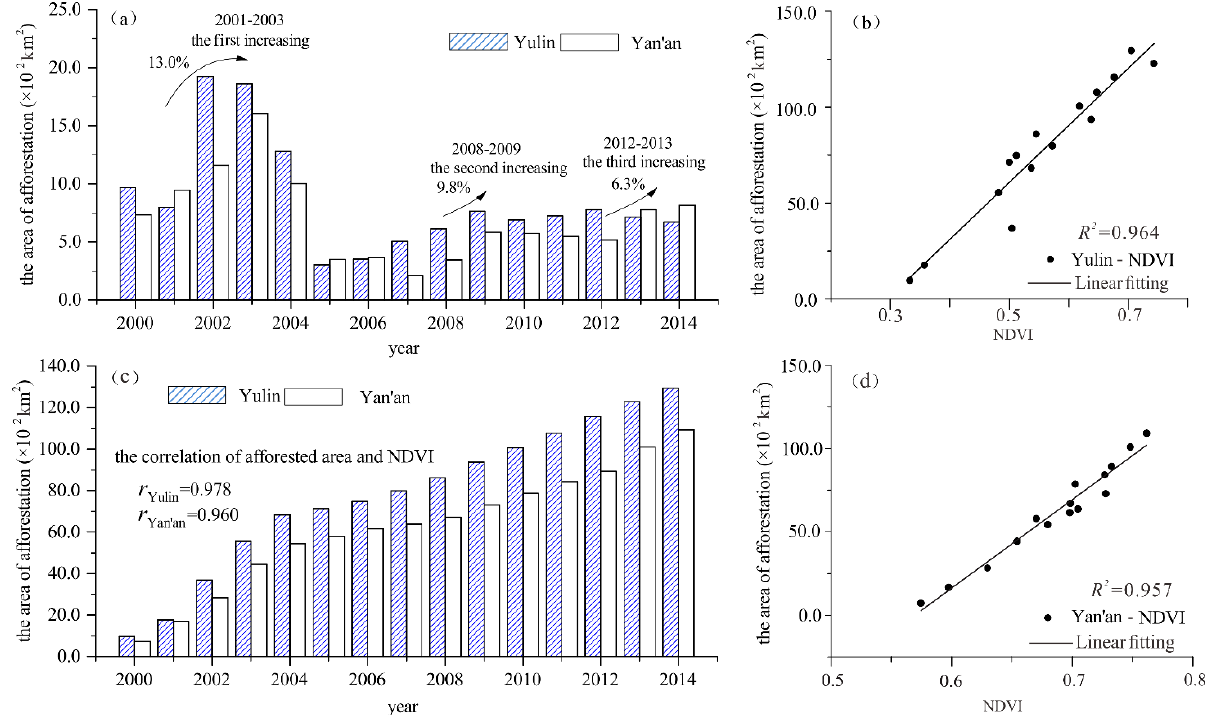
Figure 7. The relationship of NDVI and the annual afforested areas in the northern part of Shaanxi Province from 2000 to 2014; ( a ) Annual afforested areas in the northern part of Shaanxi Province from 2000 to 2014; ( b ) A scatter diagram of NDVI values and the cumulative afforested area in Yulin from 2000 to 2014; ( c ) The cumulative afforested area in the northern part of Shaanxi Province from 2000 to 2014; ( d ) A scatter diagram of NDVI values and the cumulative afforested area in Yan’an from 2000 to